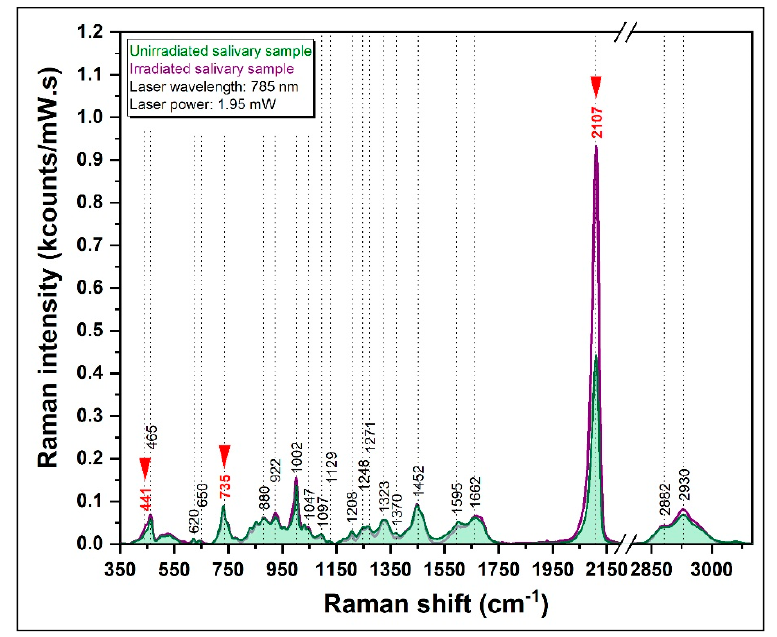
Figure 7. Superposition of the SER spectra recorded before (green spectra) and after irradiation (purple spectra) for one of the patients involved in this study. The spectra have been recorded using an excitation wavelength of 785 nm.